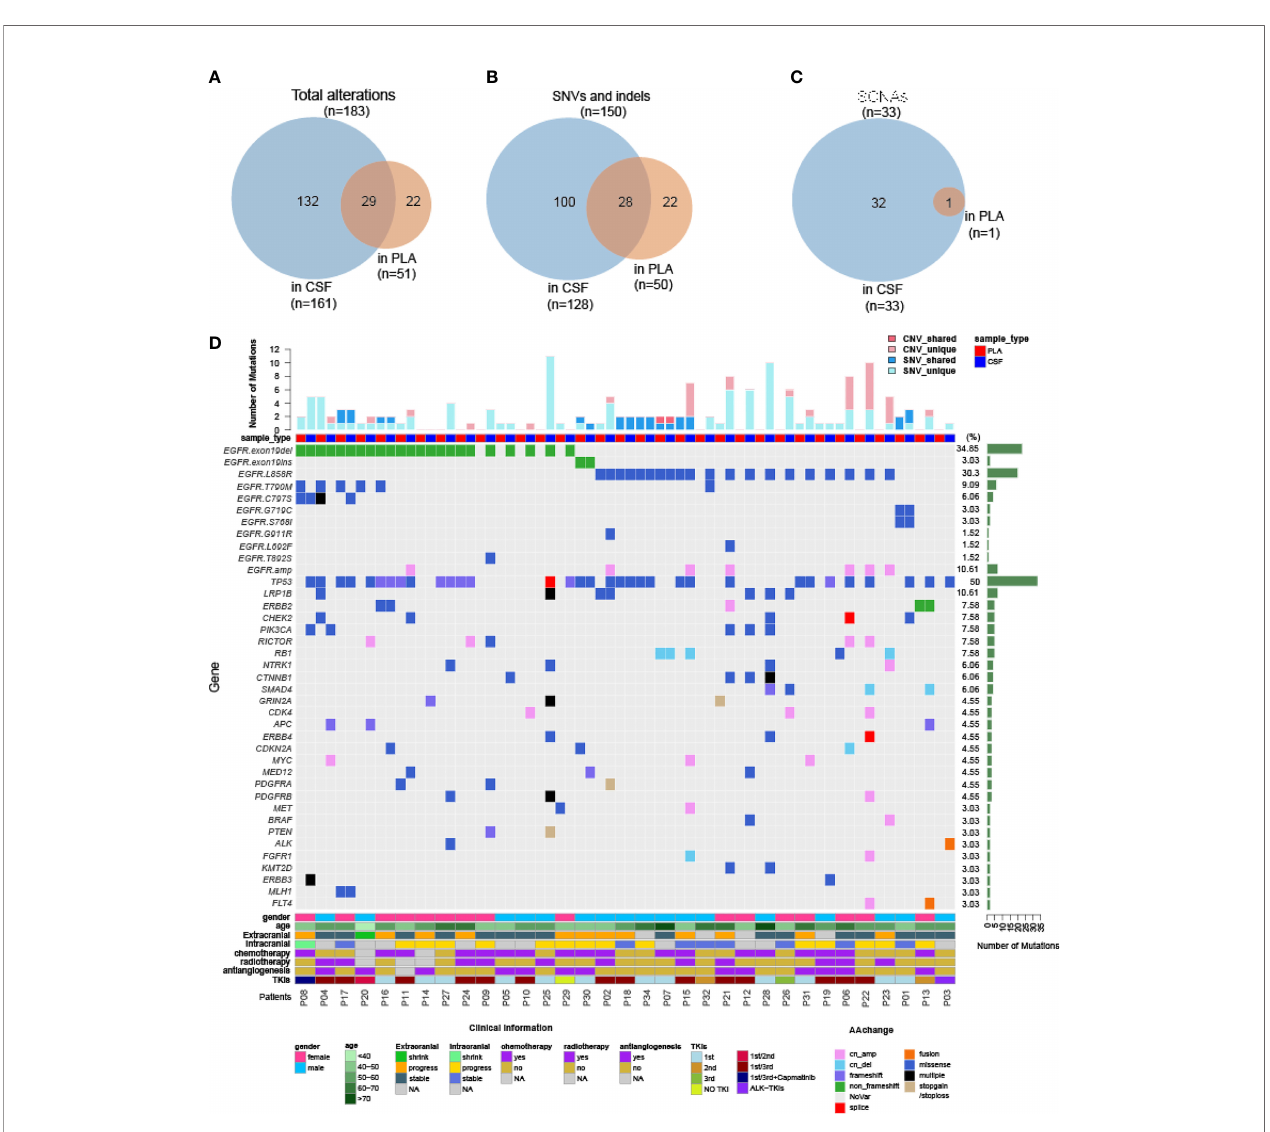
FIGURE 3 | Genomic landscape of CSF and plasma cfDNA in NSCLC with LM. Samples were subject to targeted sequencing by different vendors; a fi nal analysis for 84 core genes was performed, and the results were compared between CSF and plasma. (A – C) Venn diagram of genetic alterations for CSF- and plasma-based cfDNA pro fi ling. (A) Venn diagram of total alterations detected in CSF cfDNA and plasma (PLA) cfDNA. (B) Venn diagram of single-nucleotide variants (SNVs) and indels detected in CSF cfDNA and PLA cfDNA. (C) Venn diagram of somatic copy number alterations (SCNAs) detected in CSF cfDNA and PLA cfDNA. (D) Mutational landscape in plasma cfDNA and matched CSF cfDNA from individual patients. The number of SNVs and SCNAs are shown at the top of the panel, and clinical information is shown at the bottom of the